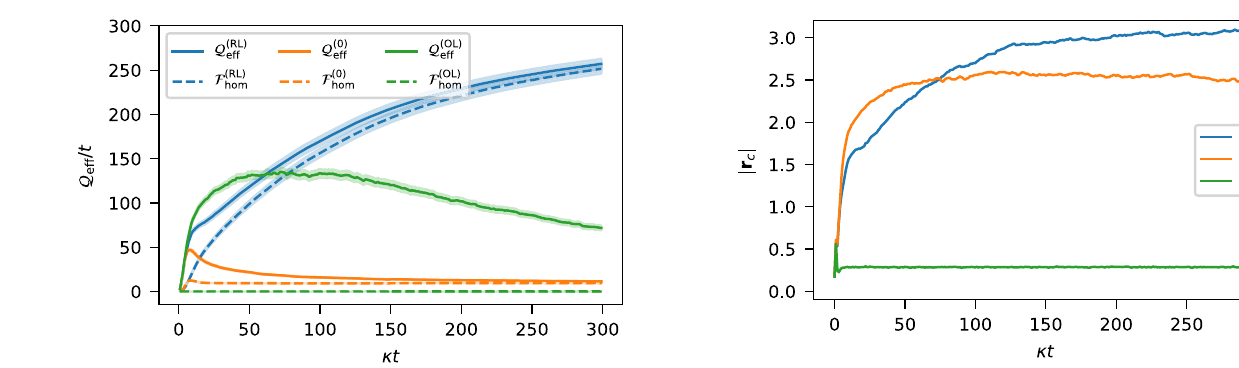
FIG. 3. E traj [ |¯ r c | ] as a function of time for the three proto- FIG. 2. Comparison of the performance of the feedback strat- cols considered (from top to bottom, RL feedback, no control, egy devised by the neural network with the performances of the and open-loop control). The results are obtained by simulating two benchmark strategies described in the main text as a func- N = 5000 trajectories with time step dt = 0.001 /κ , by fixing the , tion of time. Solid lines correspond to the effective QFI ( Q ( RL ) eff other parameters as ω = 0.1, χ = 0.49 κ , and η = 0.9, and by Q ( 0 ) , and Q ( OL ) ) divided by time, while dashed lines corre- eff eff considering as an initial state a thermal state with n th = 5 and spond to the continuous-monitoring classical Fisher information initial first-moment vector ¯ r c ( 0 ) = ( 0, 0 ) , F ( 0 ) , and F ( OL ) ) divided by time. The average QFI of ( F ( RL ) hom hom hom ¯ Q ( RL ) ¯ Q ( 0 ) ¯ Q ( OL ) the conditional states ( , , and ) can be derived c c c as the difference between the two curves above. The results are obtained by simulating N = 5000 trajectories with time step dt = 0.001 /κ , by fixing the other parameters as ω = 0.1 κ , χ = 0.49 κ , and η = 0.9, and by considering as an initial state a thermal state with n th = 5 and initial first-moment vector ¯ r c ( 0 ) = ( 0, 0 ) .